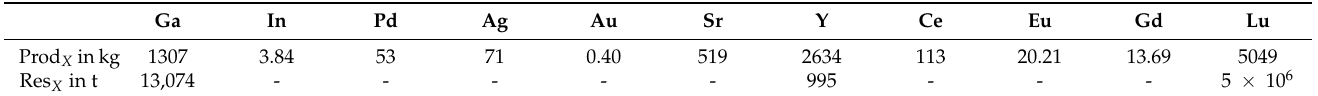
Table 4. Annual amounts of Ga, In, Pd, Ag, Au, Sr, Y, Ce, Eu, Gd and Lu required for the produc- tion of LED packages sold in the European Union between 2022 and 2030 in kg (Prod X ) and the corresponding amount of primary resources needed for the production of Ga, Y and Lu in t (Res X